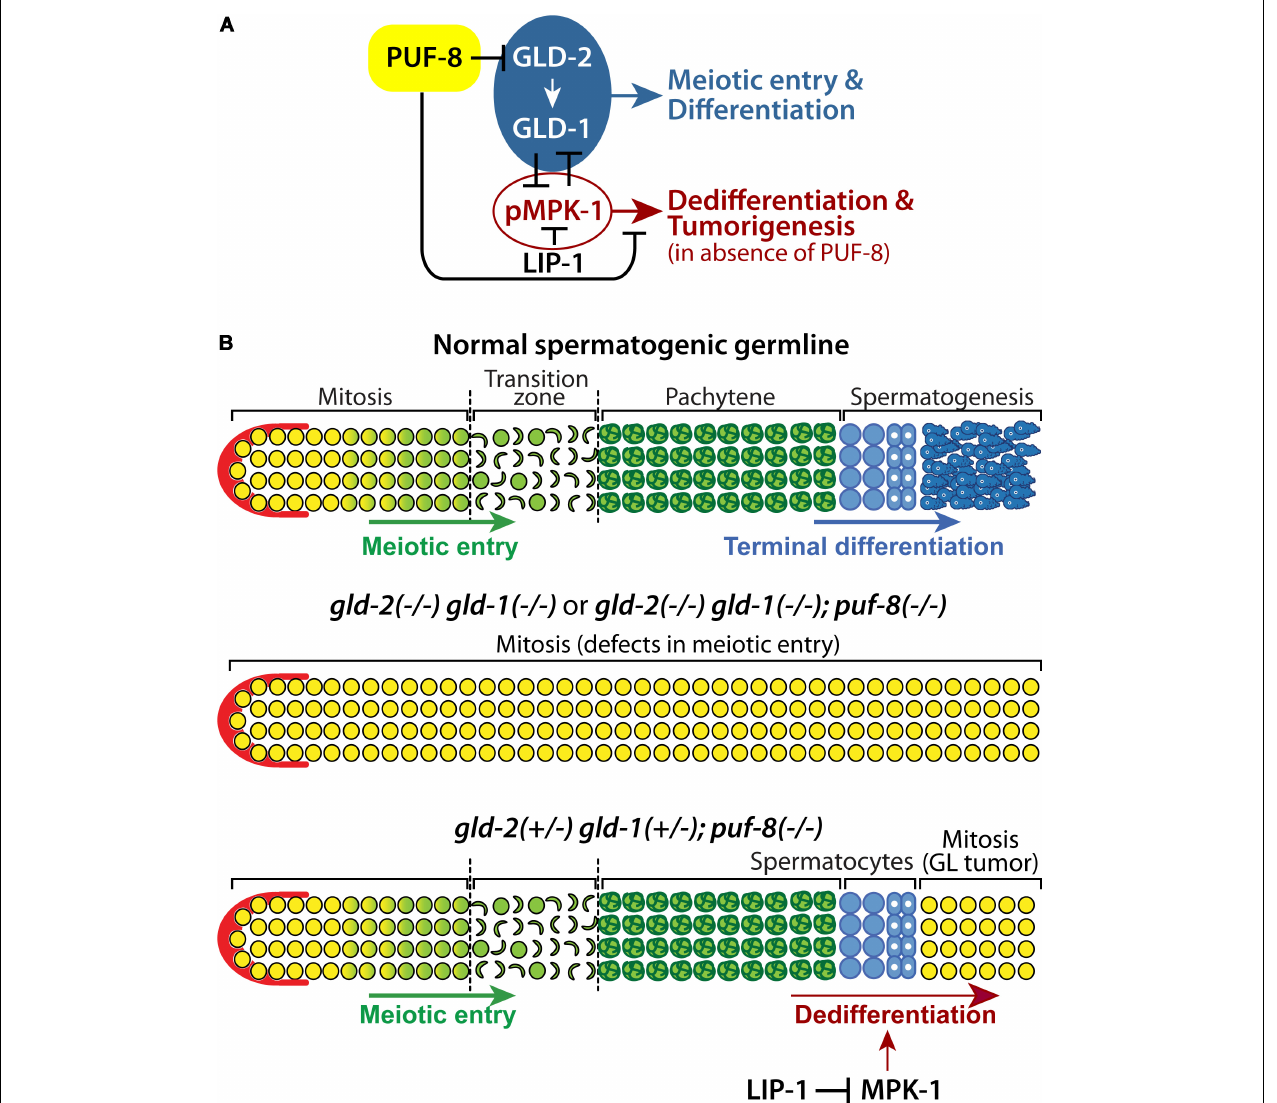
FIGURE 7 | A proposed regulatory network that controls germline differentiation, dedifferentiation, and tumorigenesis. (A) PUF-8 represses both germline differentiation and dedifferentiation (and tumorigenesis) by inhibiting GLD-2 and MPK-1 signaling. (B) In a normal spermatogenic germline (top), increased GLD-2 and GLD-1 promote germline differentiation. In gld-2(–/–) gld-1(–/–) or gld-2(–/–) gld-1(–/–); puf-8(–/–) mutant germlines (middle), germ cells fail to enter meiotic cell cycle and continue to proliferate, resulting in germline tumors. In gld-2( + / − ) gld-1( + / − ); puf-8(–/–) mutant germline (bottom), germ cells enter meiotic cell cycle, but spermatocytes return into mitotic cell cycle through dedifferentiation-like mechanism at 25 ◦ C. Dedifferentiation-mediated germline tumors depend on MPK-1